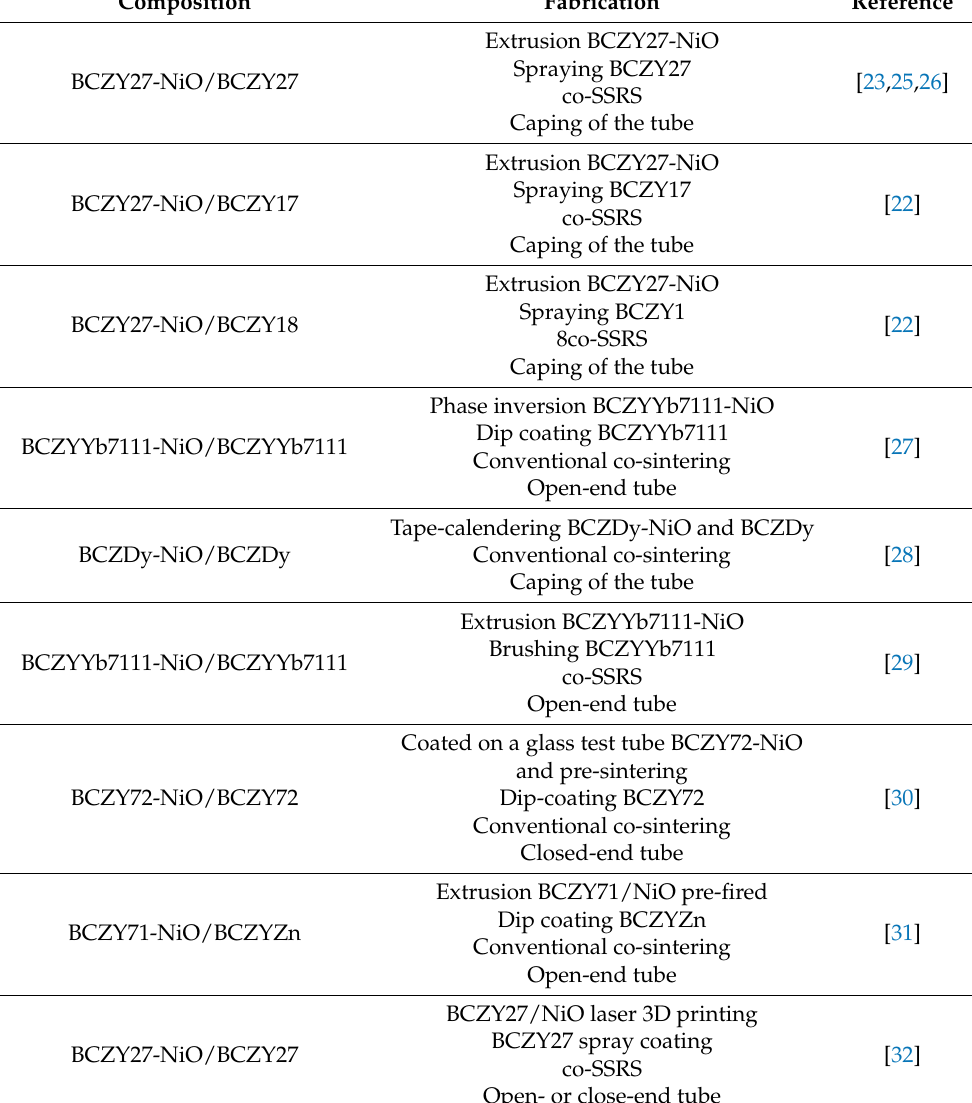
Table 1. Relevant literature data on tubular protonic-ceramic-based